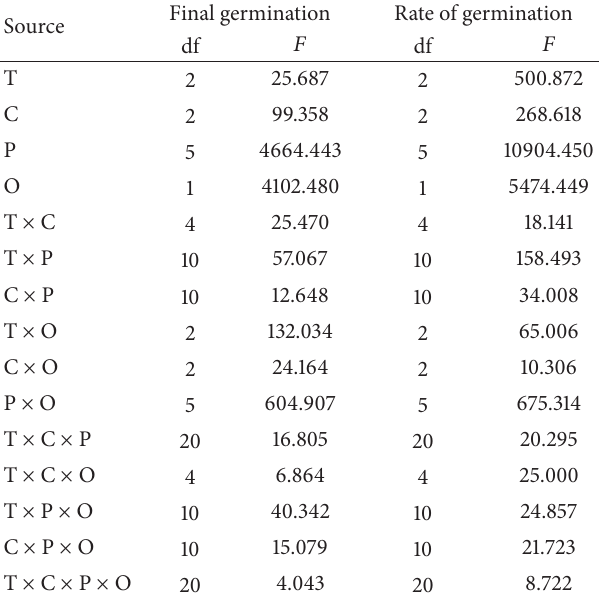
Table 1: Results of four-way ANOVA of temperature (T), cultivar (C), water potential (P), and osmoticum (O) effects on final germi- nation percentage and germination rate. All values are significant at 𝑃 < 0.05